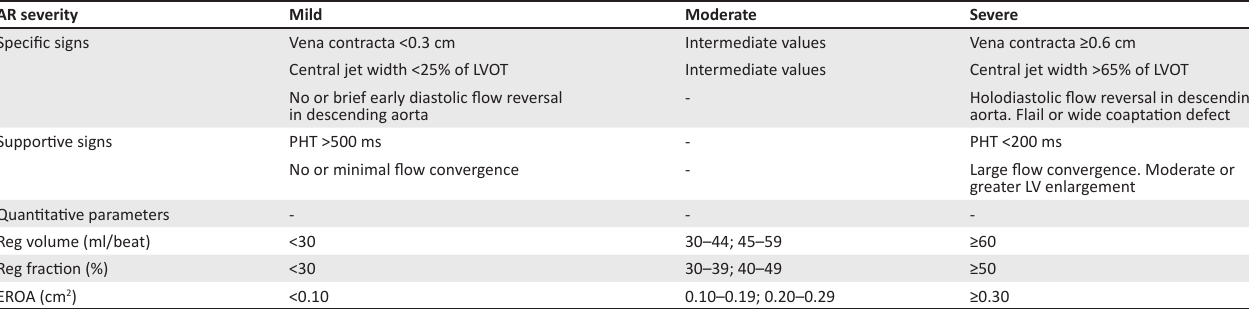
TABLE 1: Sellers proposed echocardiogram grading for aortic